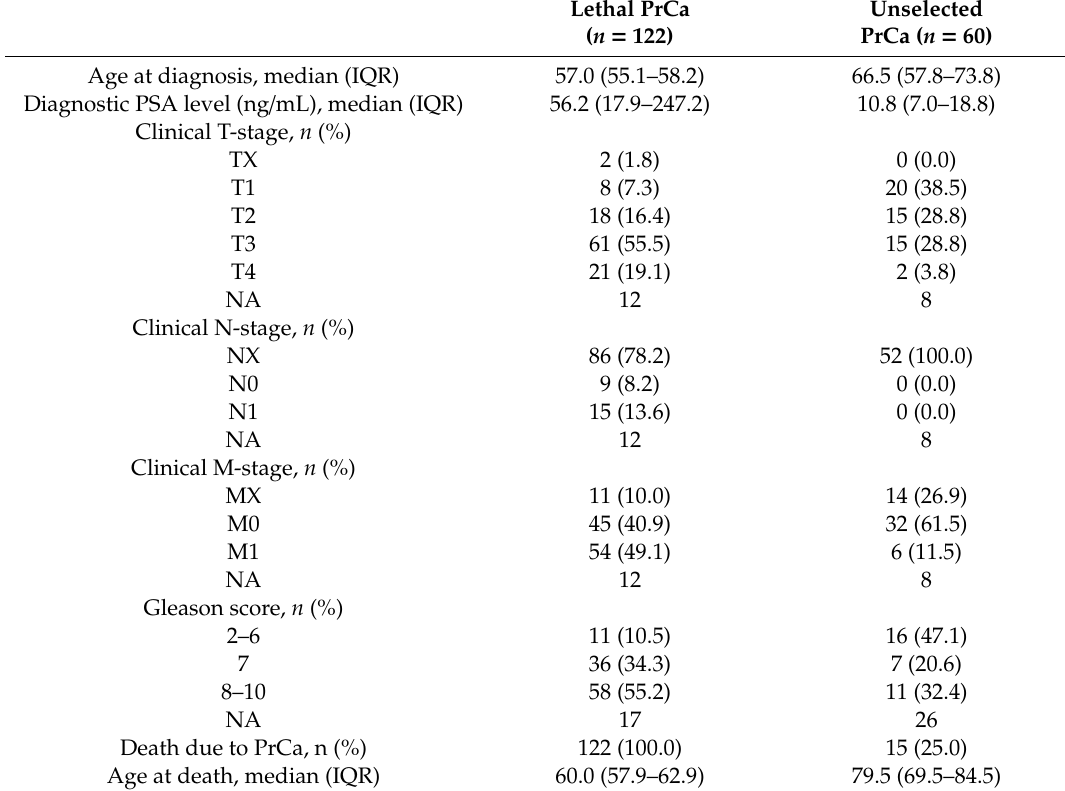
Table 1. Clinical characteristics of